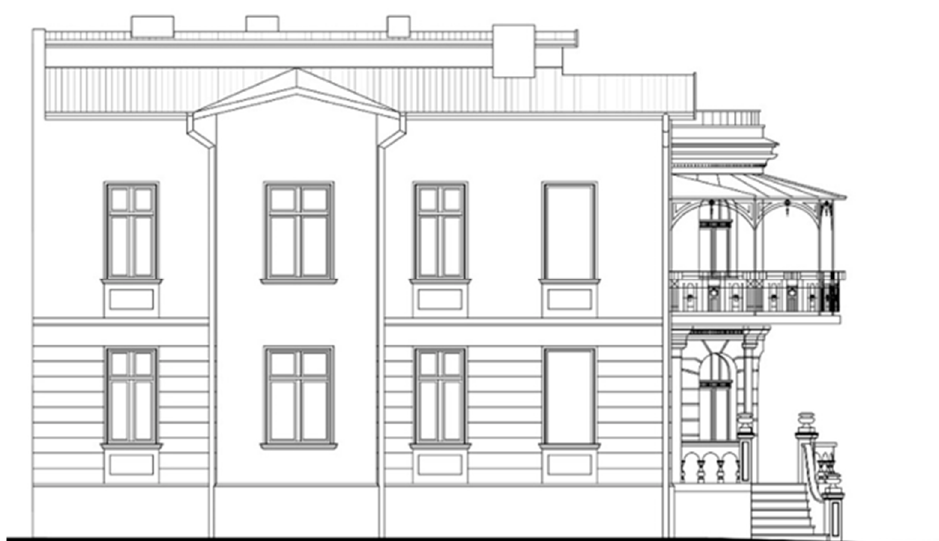
Figure 7. Willa Halina side elevation (south). Source: A. Taraszkiewicz.